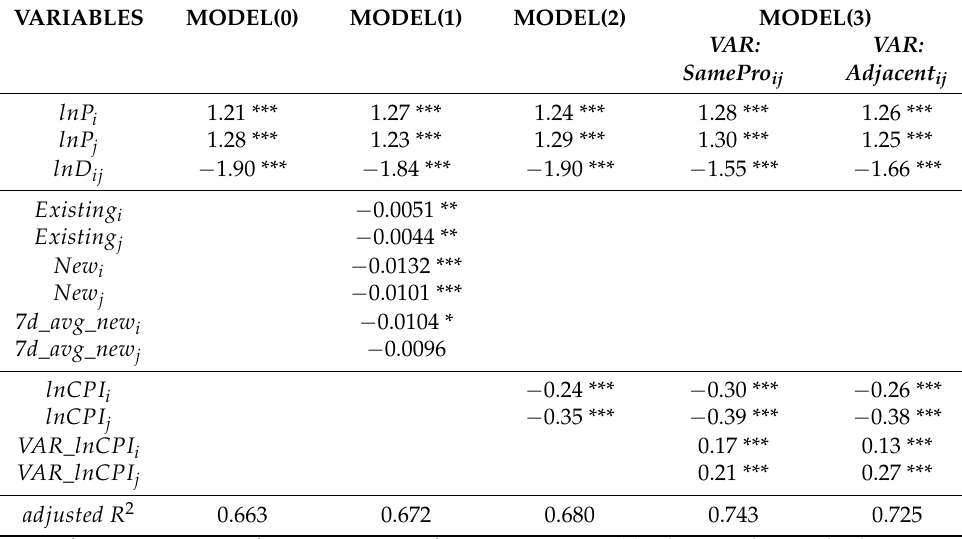
Table 3. Regression results of the modified gravity